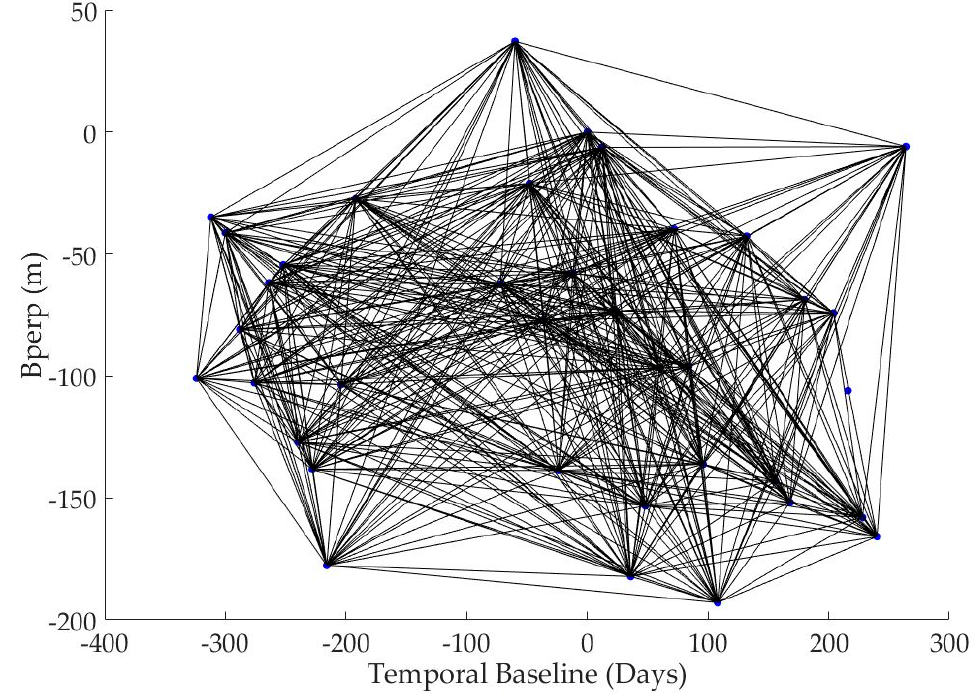
Figure 4. Sentinel-1 Synthetic Aperture Radar (SAR) temporal and perpendicular baselines of image pairs relative to the master acquired on 25 January 2016.